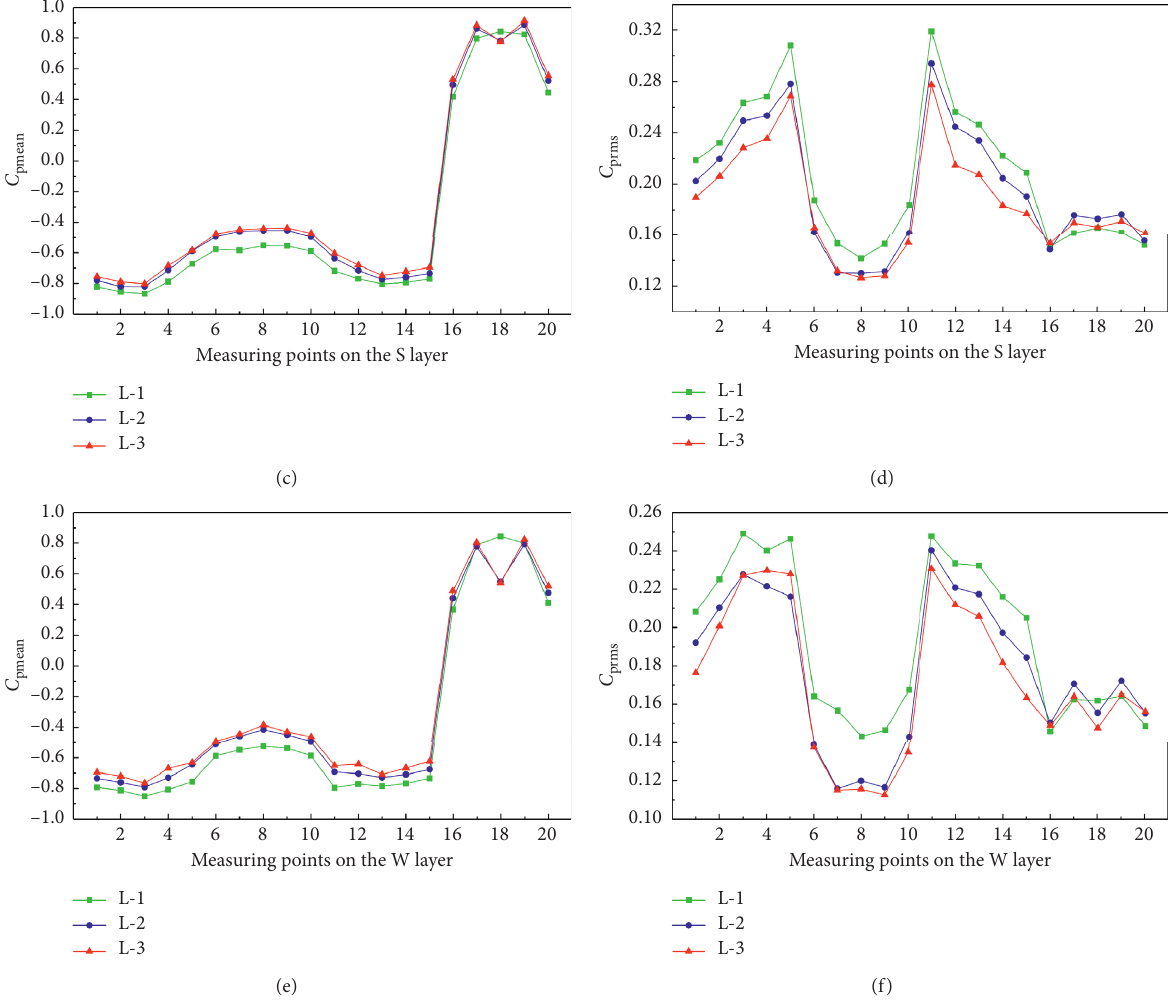
Figure 20: Mean wind pressure and fluctuating wind pressure distribution of typical measuring layers. (a) Mean pressure coefficients on layer P. (b) Fluctuating pressure coefficients on layer P. (c) Mean pressure coefficients on layer S. (d) Fluctuating pressure coefficients on layer S. (e) Mean pressure coefficients on layer W. (f) Fluctuating pressure coefficients on layer